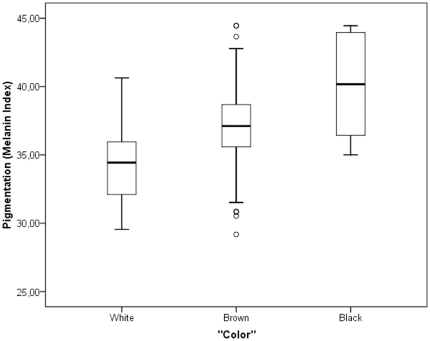
Melanin Index and “Color”.